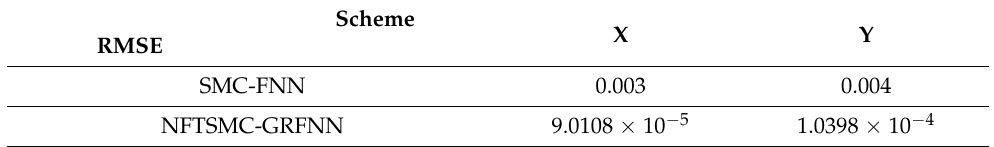
Table 1. Comparison of the RMSE between NFTSMC ‐ GRFNN and SMC ‐ FNN.